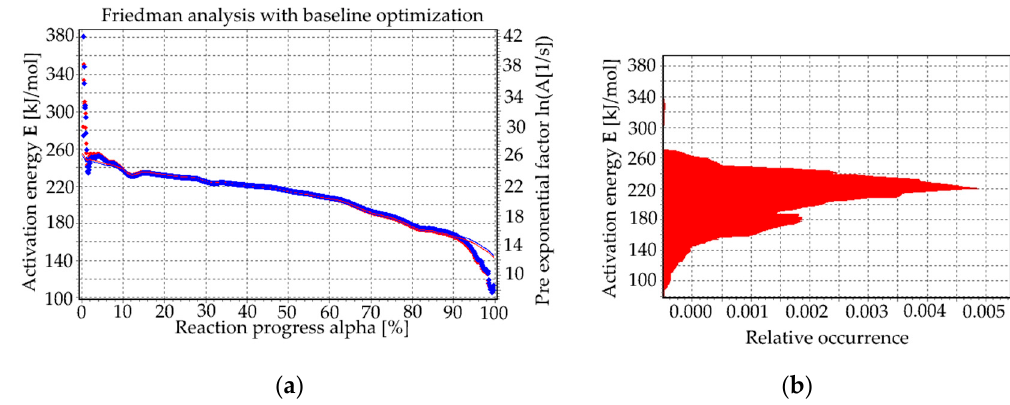
Figure 5. ( a) Activation energy as a function of the reaction progress; ( b ) histogram of the activation energy.